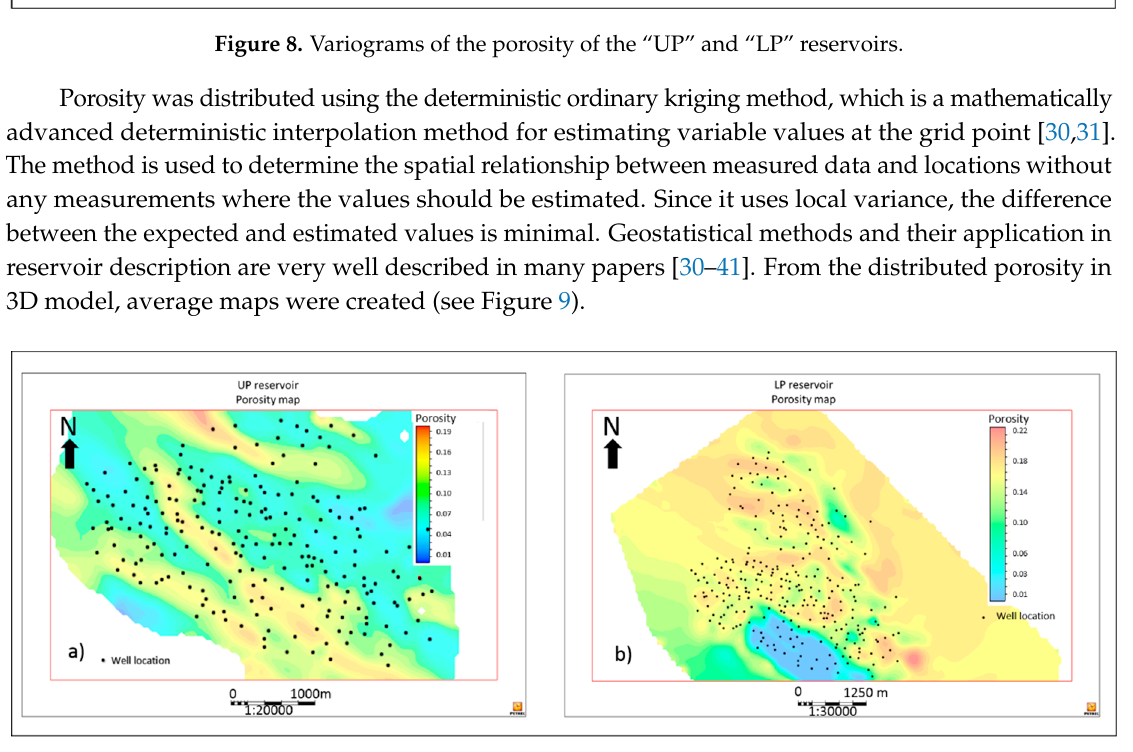
Figure 9. Porosity map of the ( a ) “UP” reservoir and ( b ) “LP” reservoir.